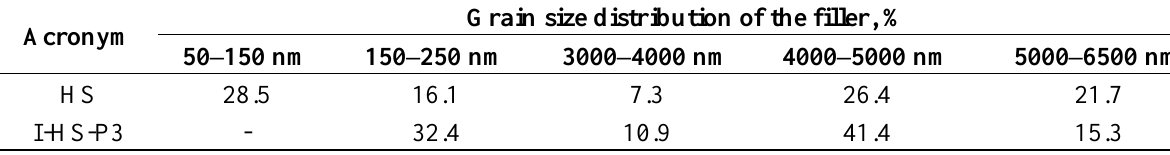
Table 4. Summary of results for grain size distribution of unmodified silica (HS) and silica modified with POSS 3